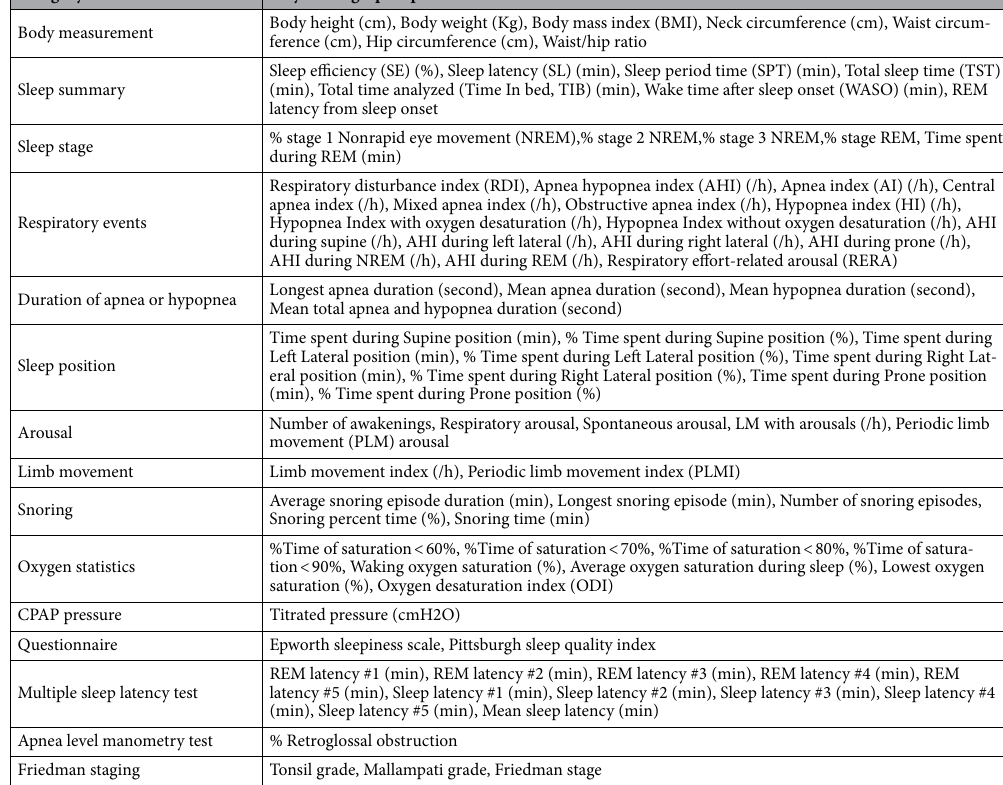
Table 1. Polysomnographic parameters included in the Observational Medical Outcomes Partnership (OMOP) Common Data Model (CDM)